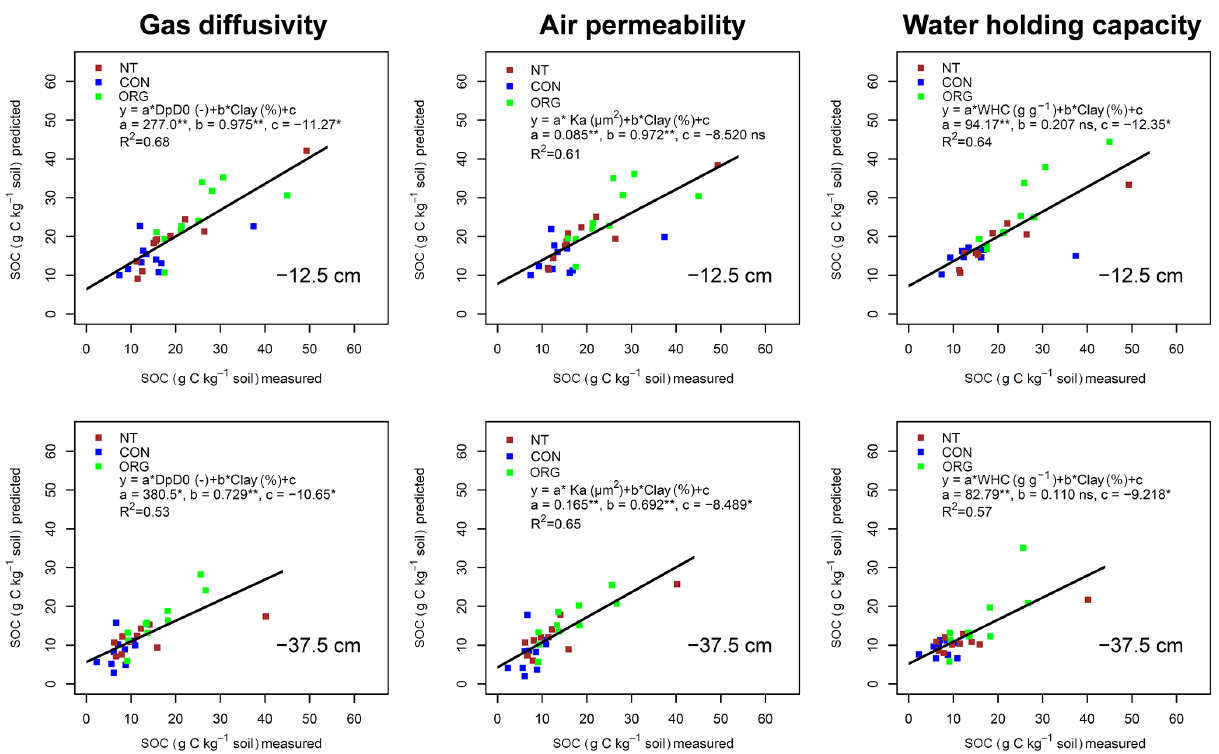
Figure 4. Multiple linear regression models (Eq. 3) to explain soil organic carbon content as a function of gas diffusion coefficients ( Dp/D 0 in − , air permeability – Ka – in µm 2 ) measured at 100hPa matric suction, water holding capacity (WHC in g 3 g − 3 ), and clay content (Clay in %). NT (red), CON (blue), and ORG (green) denote no-till, conventional, and organic management system, respectively. ∗∗ and ∗ indicate significant regression coefficients at p< 0 . 01 and p< 0 . 05, respectively, and ns indicates non-significant regression coefficients. R 2 represents multiple r -squared